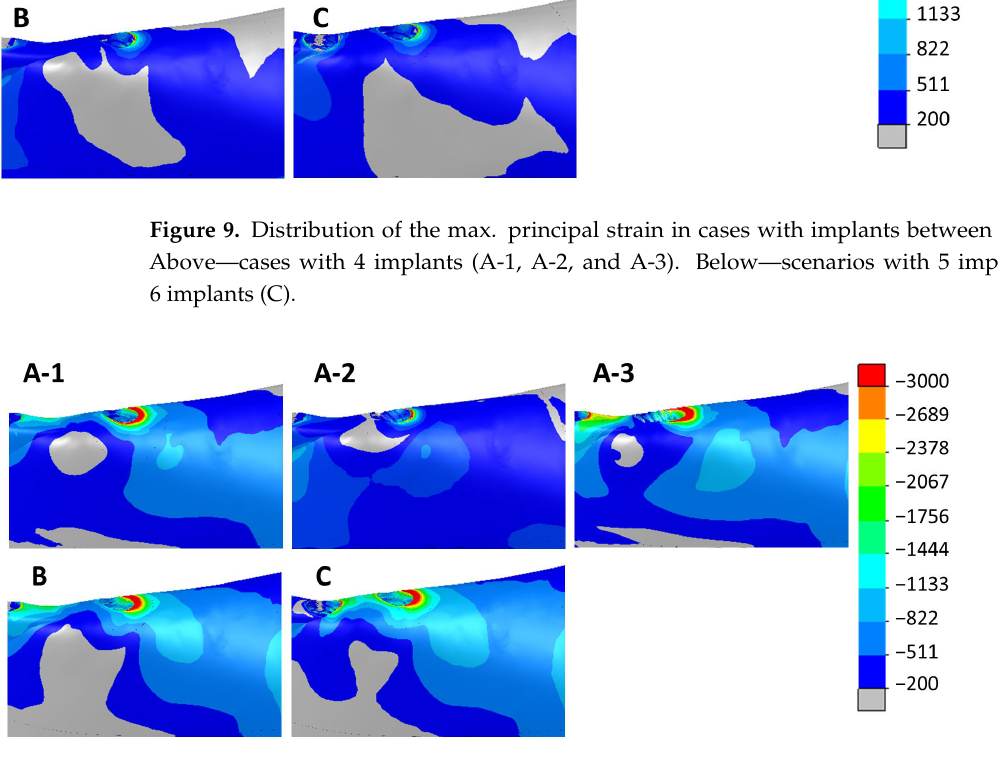
Figure 10. Distribution of the min. principal strain in cases with implants between the foramina. Above—cases with 4 implants (A-1, A-2, and A-3). Below—scenarios with 5 implants (B) and 6 implants (C).